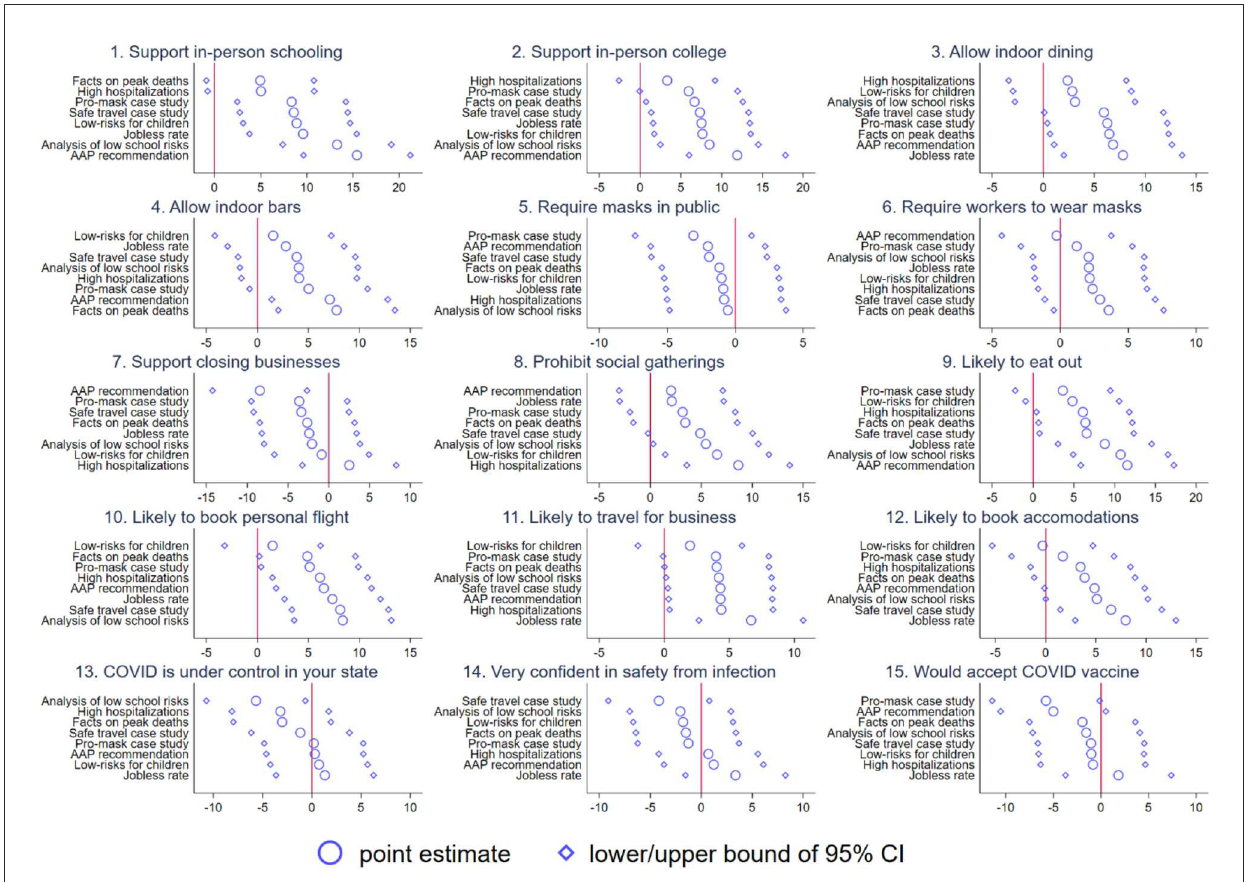
FIGURE2 The causal effect of COVID-19 information on policy preferences, consumer behavior, and beliefs. Each figure plots the coefficients from the baseline model. 95% confidence intervals are